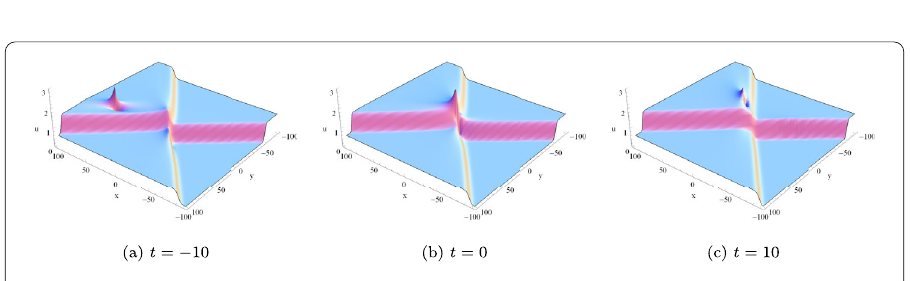
Figure 6 Plot of one lump and two kink solitons interaction with parameters p 1 = 0.3 – 0.4 i , p 2 = 0.5 + 0.6 i , c 11 = c 21 = 1, γ 11 = γ 22 = 1, γ 12 = γ 21 =